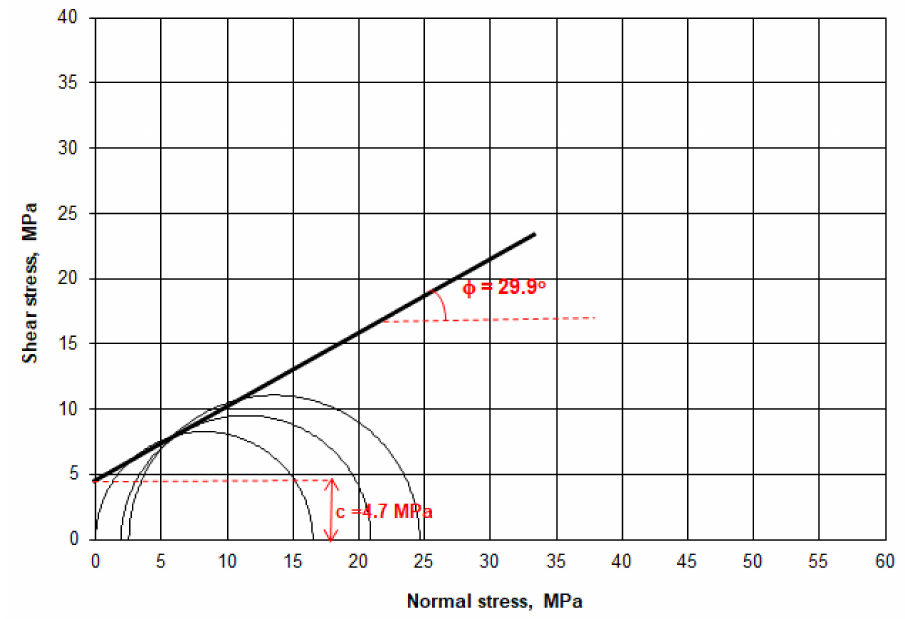
Figure 11. Mohr–Coulomb failure envelopes in terms of normal and shear stress for porosity of the zeolite-bearing rock n > 24%. Determined parameters are c = 4.7 MPa and Φ = 29.9 ◦